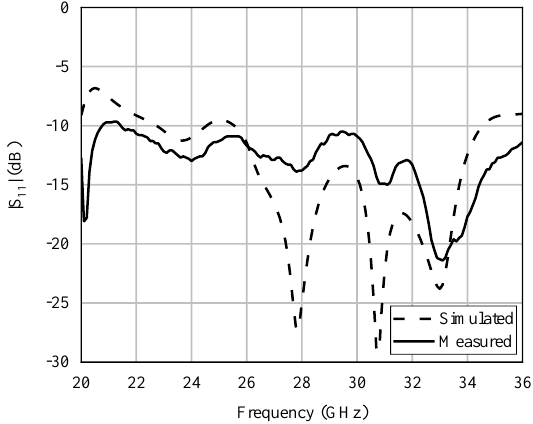
Figure 11. Simulated and measured |S 11 | versus frequency.